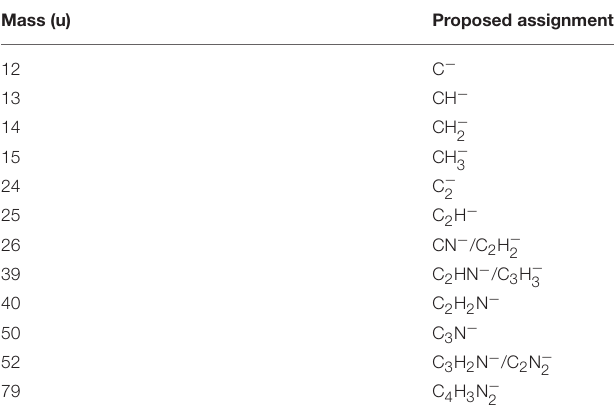
TABLE 1 | Negative ions formed in potassium collisions with pyrimidine (Pyr). Mass (u) Proposed